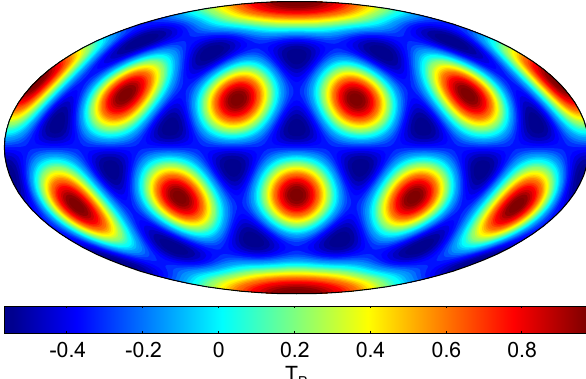
Figure 7. θ − λ temperature dependence of the dodecahedral initial condition (Eq. 10).